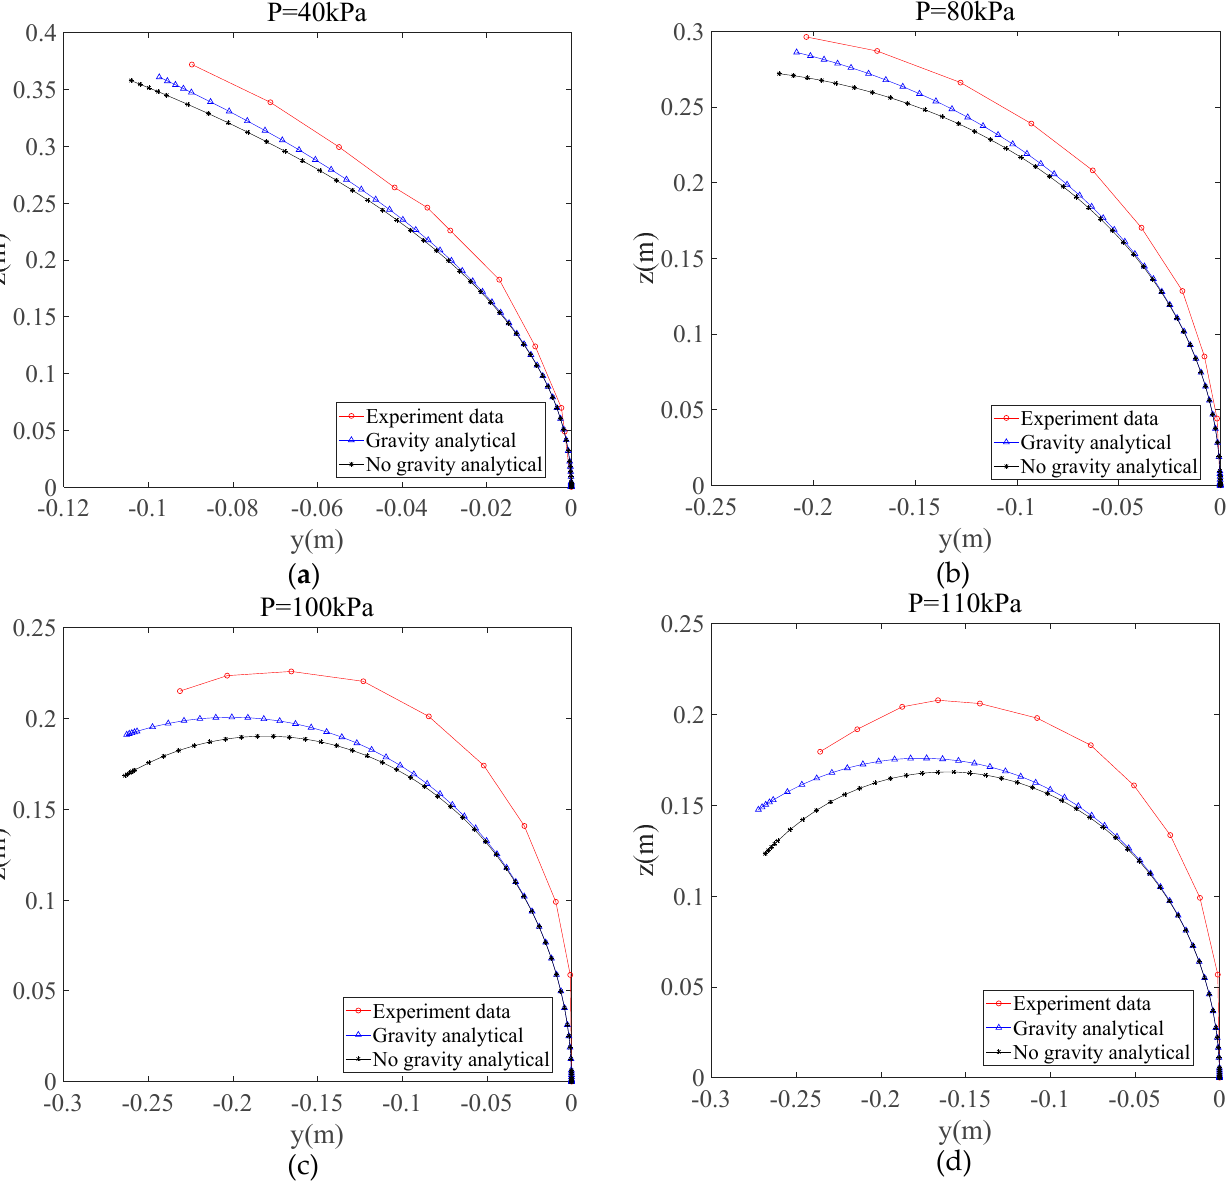
Figure 9. Length of soft actuator and analytical model prediction results under various pressures. ( a ) The inner pressure of the soft fiber-reinforced bending actuator was 40 kPa, ( b ) 80 kPa, ( c ) 100 kPa, and ( d ) 110 kPa.